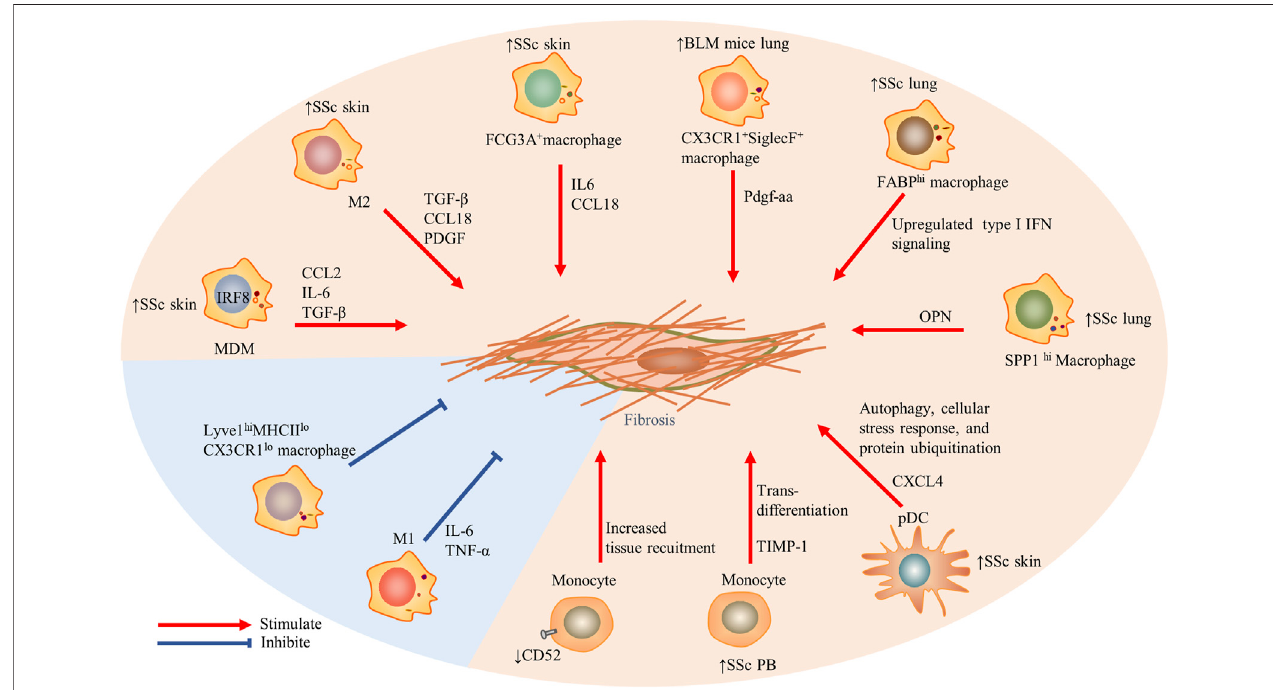
FIGURE 1 | The role of innate immune cells including monocytes, macrophages, and dendritic cells in the fi brosis in SSc. Particularly, Lyve1 hi MHCII lo CX3CR1 lo macrophages restrained induced tissue fi brosis, and traditional M1 macrophages also prevented fi brosis. Red arrows indicate stimulation; blue blunted-ends indicate inhibition. SSc, systemic sclerosis; PB, peripheral blood; IRF, interferon regulatory factor 8; MDM, monocytes-derived macrophages; CCL, CC chemokine ligand; IL, interleukin; IFN, interferon; OPN, osteopontin; TIMP-1, tissue inhibitor of metalloproteinases 1; and Lyve1, lymphatic endothelium hyaluronan